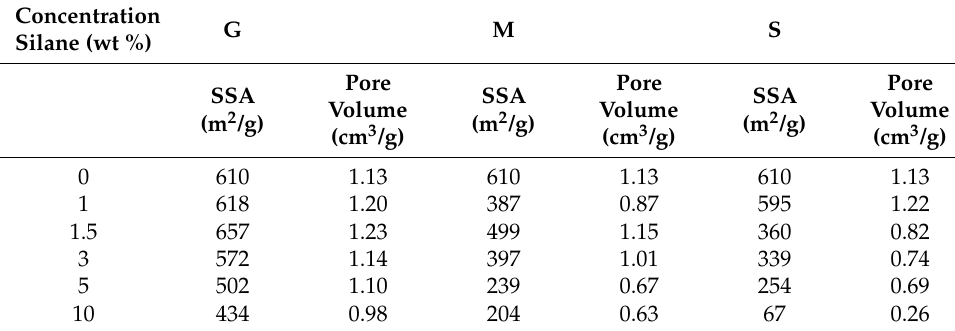
Table 1. Specific surface area of the functionalized mesoporous